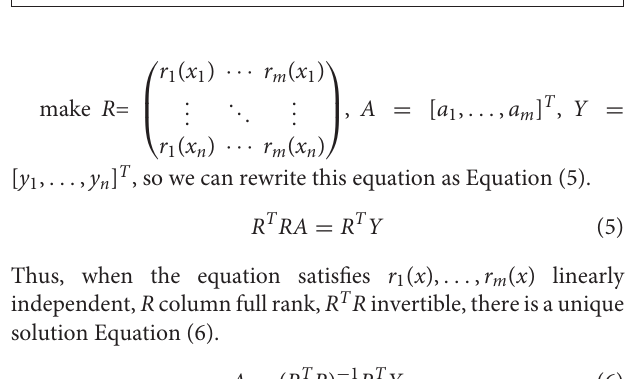
FIGURE 2 | Phase space reconstruction and the least square method were used to detect EEG signals before and after denoising in patients with